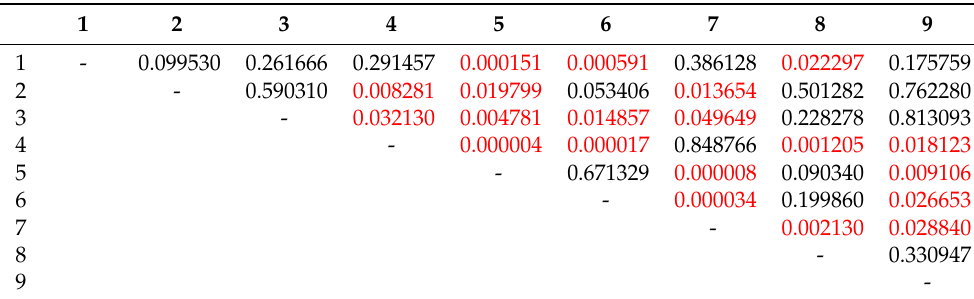
Ageing protocols: control-water, 24 h, 37 ◦ C; thermocycling + NaOH-water, 7500 thermo cycles, 5/55 ◦ C and 0.1 M NaOH, 7 days, 60 ◦ C; 5d water + NaOH-water, 5 days, 55 ◦ C and 0.1 M NaOH, 7